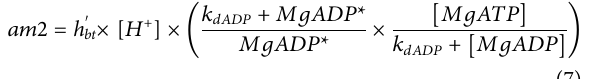
Figure 3D Human and bovine cardiac myosins Figure 5A Left ventricular single canine myocytes Figure 5B Ex vivo mouse and in vivo pig